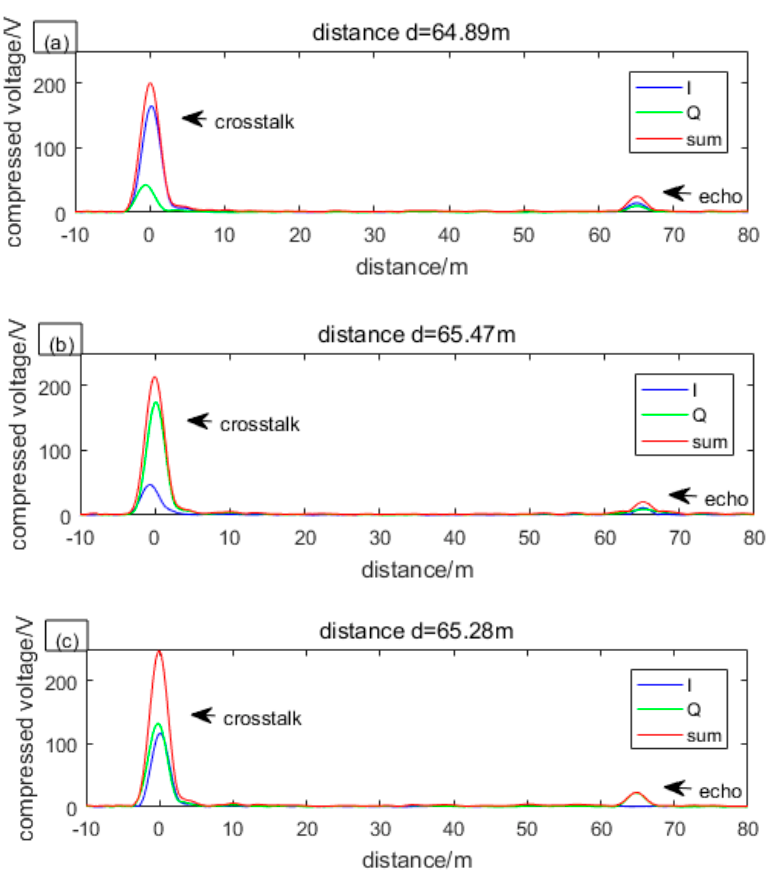
Figure 5. The compressed results of Figure 3 are listed as: (a) I is strong while Q is weak; (b) I is weak while Q is strong; (c) I and Q are almost